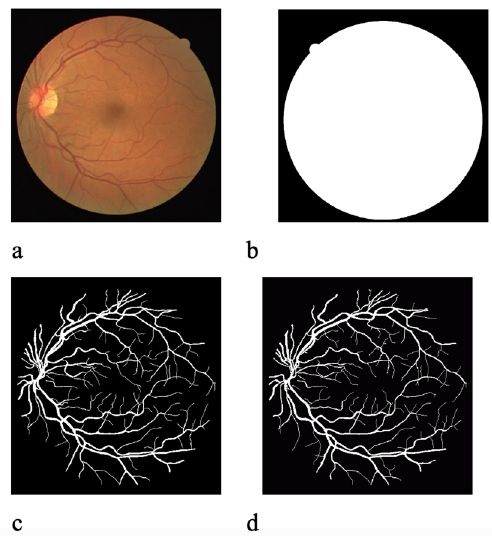
Figure 7. Result of the segmentation: ( a ) the original color image, ( b ) its mask, ( c ) its ground truth, and ( d ) the image of the retina segmented using the U-Net++ network. Table 1. Results from the image segmentation using the U-Net++ neural network on the DRIVE database.